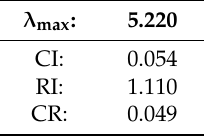
Table 8. Results of the consistency measure in AHP applied to